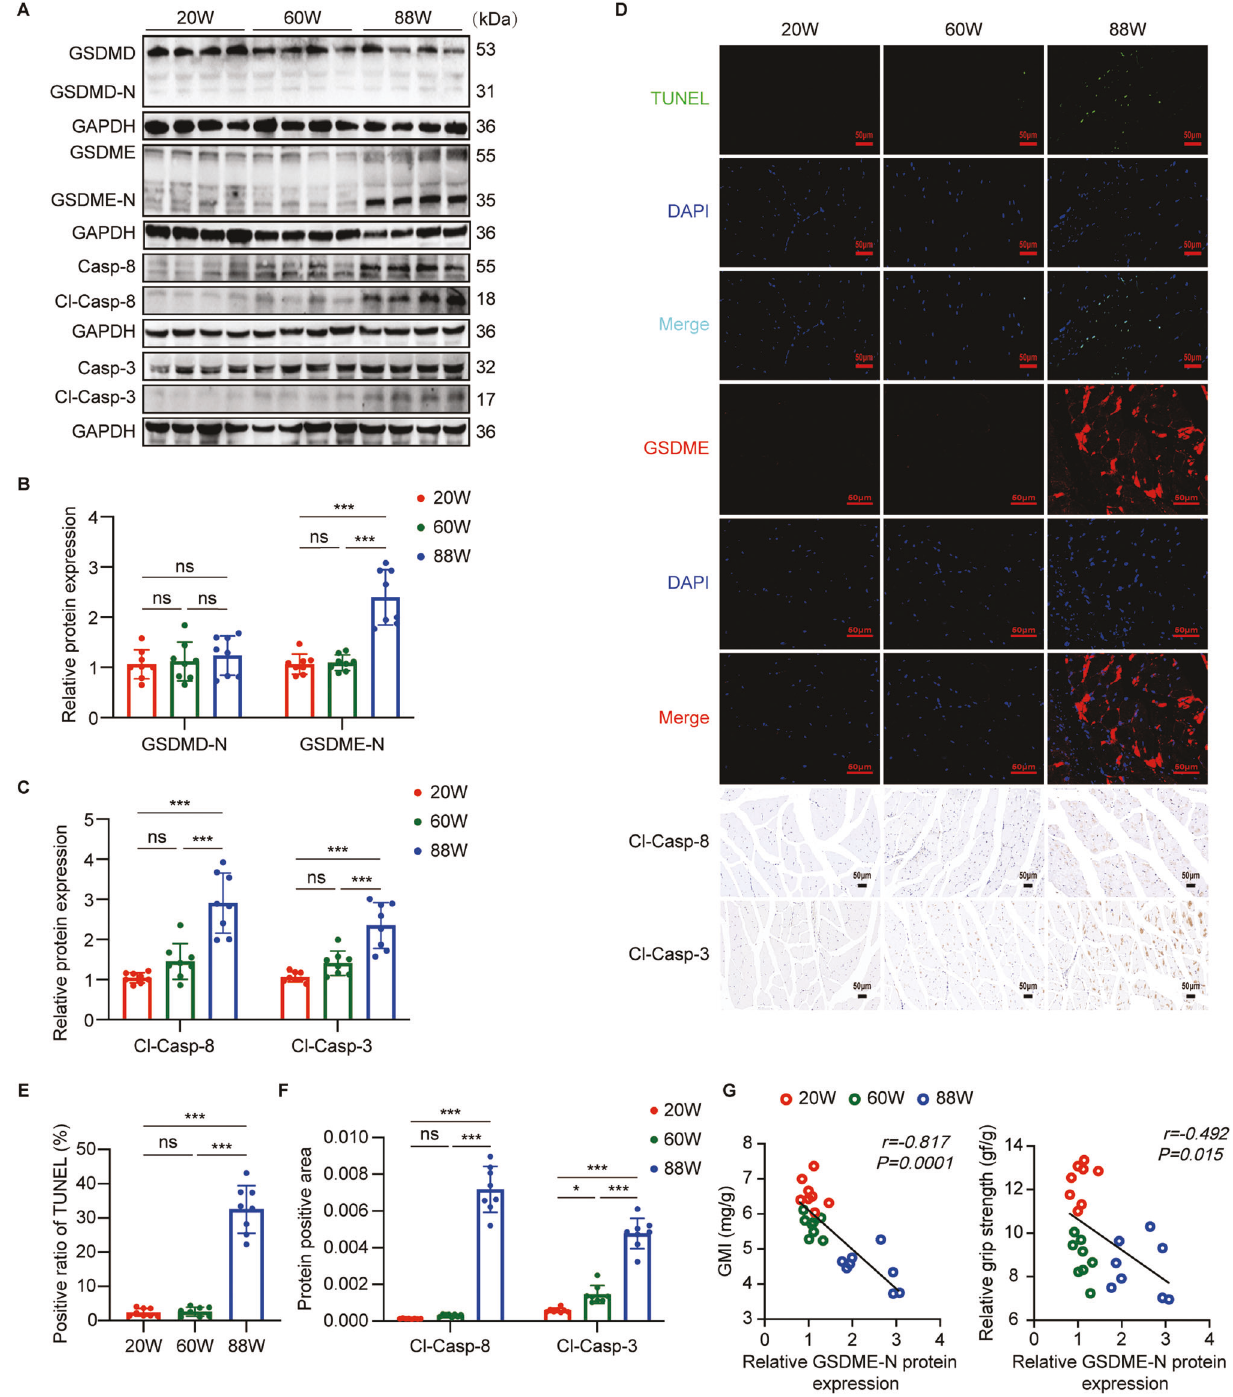
Fig. 2 GSDME-mediated pyroptosis and activation of apoptosic caspase-8/-3 were present in GM of aged mice with sarcopenia. A Representative immunoblots of GSDMD, N terminus of GSDMD(GSDMD-N), GSDME, N terminus of GSDME(GSDME-N), caspase (Casp)-8, cleaved-Casp(Cl-Casp)-8, Casp-3 and Cl-Casp-3 in GM of mice at different ages. B , C Relative expression levels of GSDMD-N, GSDME-N, Cl-Casp- 8, and Cl-Casp-3 normalized to GAPDH based on densitometric analysis of immunoblots. D TUNEL staining, immuno fl uorescence staining of GSDME and immunohistochemical staining of Cl-Casp-8 and Cl-Casp-3 in GM of mice at different ages. Scale bar: 50 μ m. E positive rates of TUNEL staining in the mice at different ages. F quantitation of immunohistochemical analyses for Cl-Casp-8 and Cl-Casp-3. G , correlation analysis of the relative expression level of GSDME-N with relative grip strength and GMI in mice. Data are expressed as mean ± SD. * P < 0.05, *** P < 0.001, ns: no signi fi cance. n = 8 mice per group.